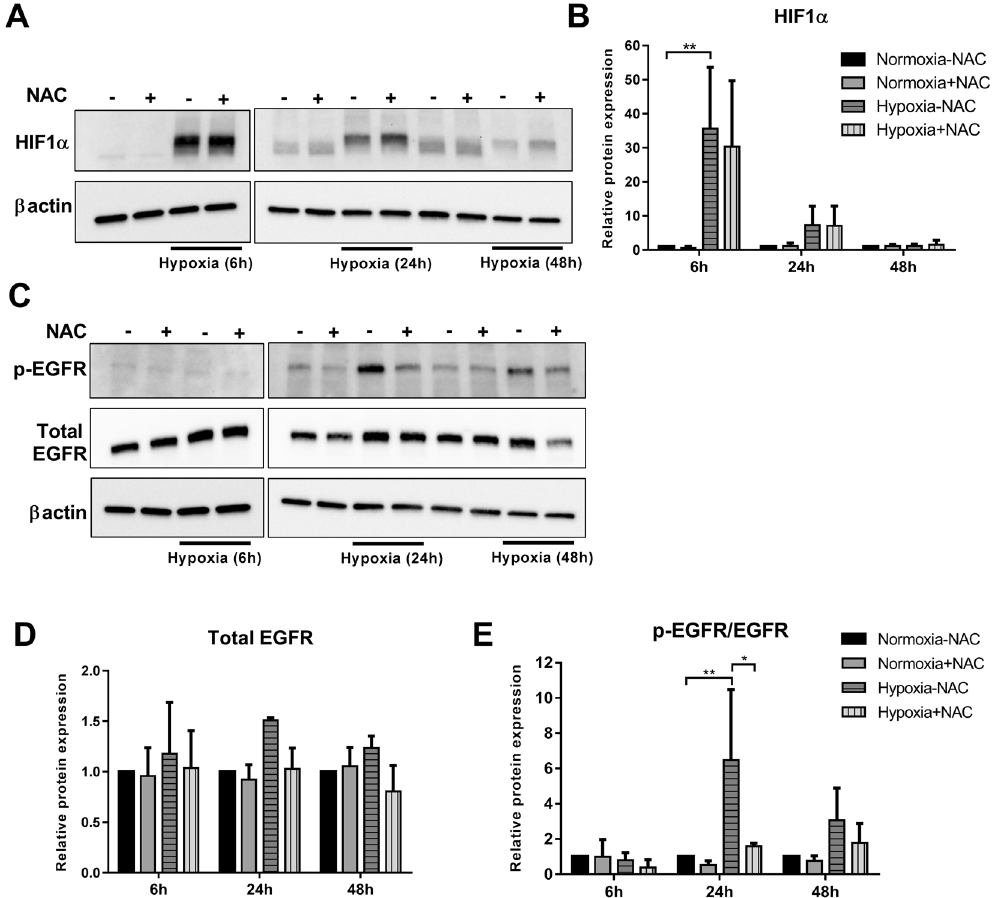
Figure 3. Effect of NAC on hypoxia-induced HIF1 α and EGFR signalling. MDA-MB-468 cells were treated with NAC (10 mM) and exposed to hypoxia for 6 h, 24 h and 48 h. ( A ) Representative cropped immunoblot and ( B ) densitometry analysis of HIF1 α protein levels (normalised to β -actin). ( C ) Representative cropped immunoblot and densitometry analysis of ( D ) total EGFR (normalised to β -actin) and phosphorylated EGFR (p-EGFR) (Y1173) levels (normalised to β -actin and total EGFR) (full-lenght immunoblots are shown in the Supplementary Fig. S2). * p < 0.01, ** p < 0.001 (two-way ANOVA, with Tukey’s multiple comparisons test). All densitometry data presented are the mean of three independent experiments ± ROS mediate the activation of hypoxia-induced EGFR but not HIF1 α . Given the redox modula- tion of hypoxia-induced gene expression of specific EMT markers, we sought to explore the involvement of ROS in the activation of two key hypoxia-associated signalling pathways HIF1 α 32 and EGFR 38 at different hypoxic time points. Exposure of cells to 6 h hypoxia significantly increased the protein levels of HIF1 α , however, NAC treatment did not have any effect on this induction (Fig. 3A and B). At 24 h hypoxia, there was a trend towards up-regulation of HIF1 α levels with hypoxia that was also insensitive to ROS scavenging. Elevated HIF1 α levels were not maintained at 48 h hypoxia (Fig. 3A and B). Hypoxia, at any time point tested, did not significantly affect the total EGFR levels, and NAC treatment also did not change these levels (Fig. 3C and D). Maximal EGFR phosphorylation at Y1173 (the major EGFR sig- nalling site 39 ) was evident at 24 h and was significantly reduced by NAC. This increase was redox dependant as treatment with NAC significantly decreased (~70%) the hypoxia-induced EGFR phosphorylation (Fig. 3C and E). At 48 h there was a trend towards reduction of both total and activated EGFR by NAC, however, this was not statistically significant. These findings provide further evidence of the specificity in the redox modulation of cel- lular signals associated with hypoxia. Hypoxia-induced N-cadherin and SERPINE1 expression and EGFR activation are not sensitive to Trolox and Tempol. To understand the detailed mechanism of redox regulation of hypoxia-induced N-cadherin and SERPINE1 expression and EGFR activation, we treated cells with Trolox and TEMPOL, two ROS scavengers with distinct mechanisms of action. Trolox, a water-soluble vitamin E analog, inhibits lipid peroxi- dation by scavenging peroxyl radicals (ROO • ) 40 . TEMPOL, on the other hand, is a superoxide dismutase (SOD) mimetic that attenuates superoxide anions 41 . Neither Trolox (10 and 100 µ M) nor Tempol (0.1 and 1 mM) inhib- ited the induction of N-cadherin and SERPINE1 mRNA expression (Fig. 4A and B) and EGFR phosphorylation by hypoxia (Fig. 4C and D). Tempol appeared to enhance the mRNA levels of N-cadherin and SERPINE1 in a